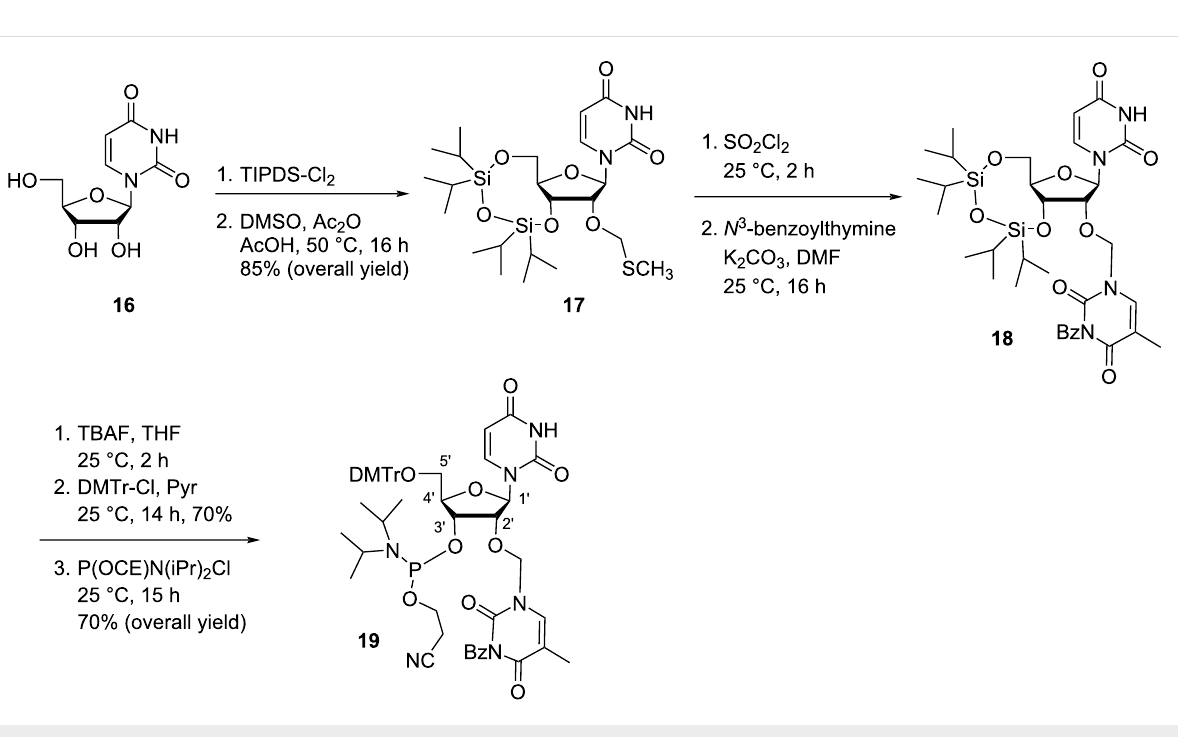
2-methylpropenoyl isocyanate in a mixture of benzene and DMF, followed by acidification with sulfuric acid affording the nucleosides 28 and 29 , respectively in high yields (Scheme 7)